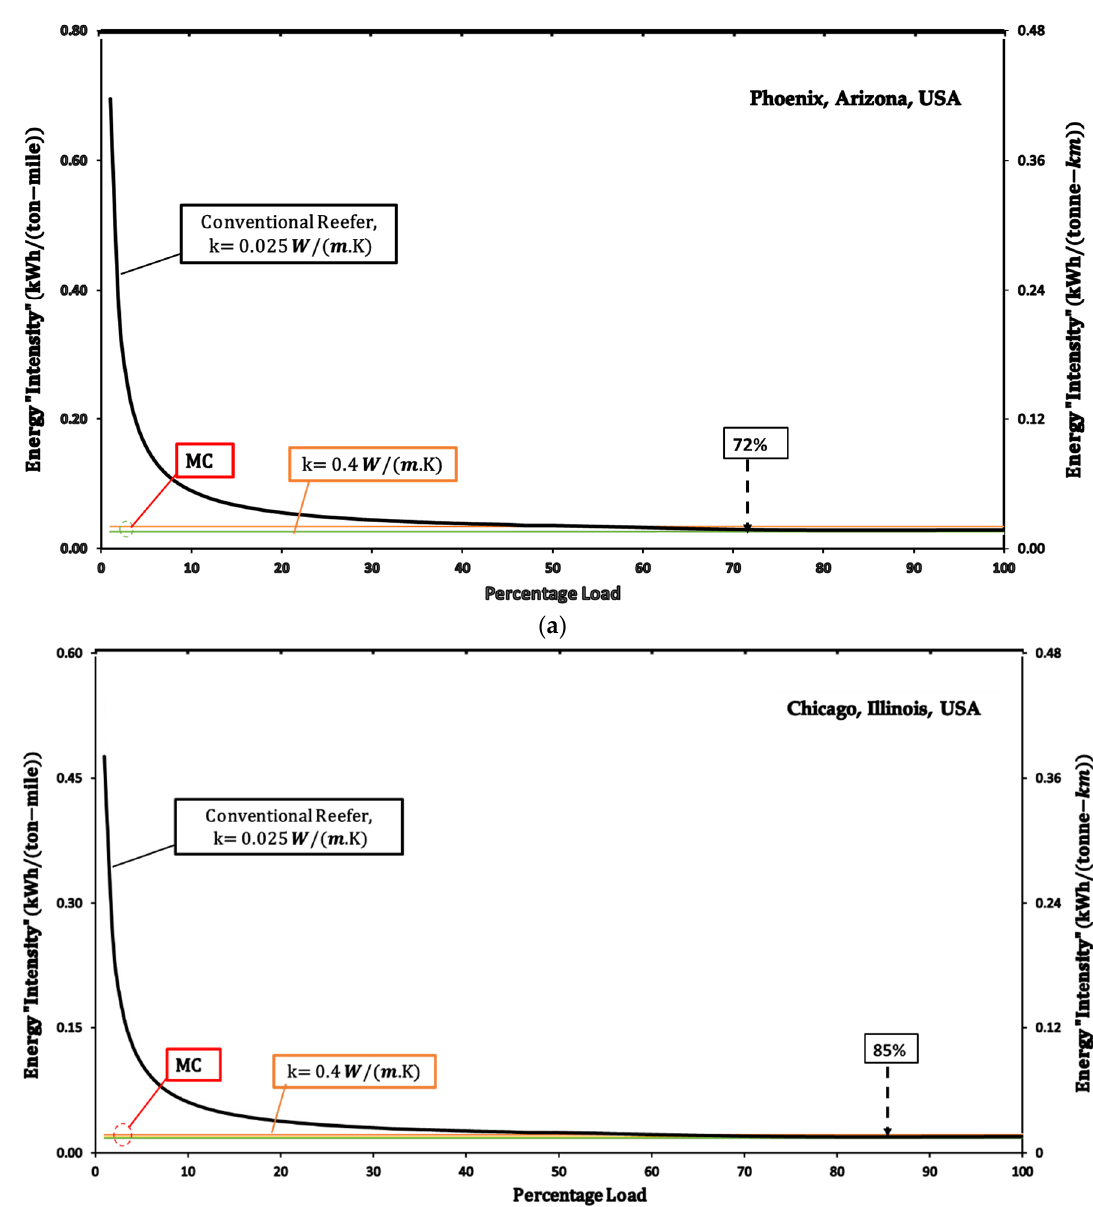
Figure 6. Conventional reefer vs. mini container refrigeration energy consumption, considering tomatoes as the cargo, for: ( a ) Phoenix, and ( b ) Chicago, in kWh per ton-mile and kWh per tonne-km.